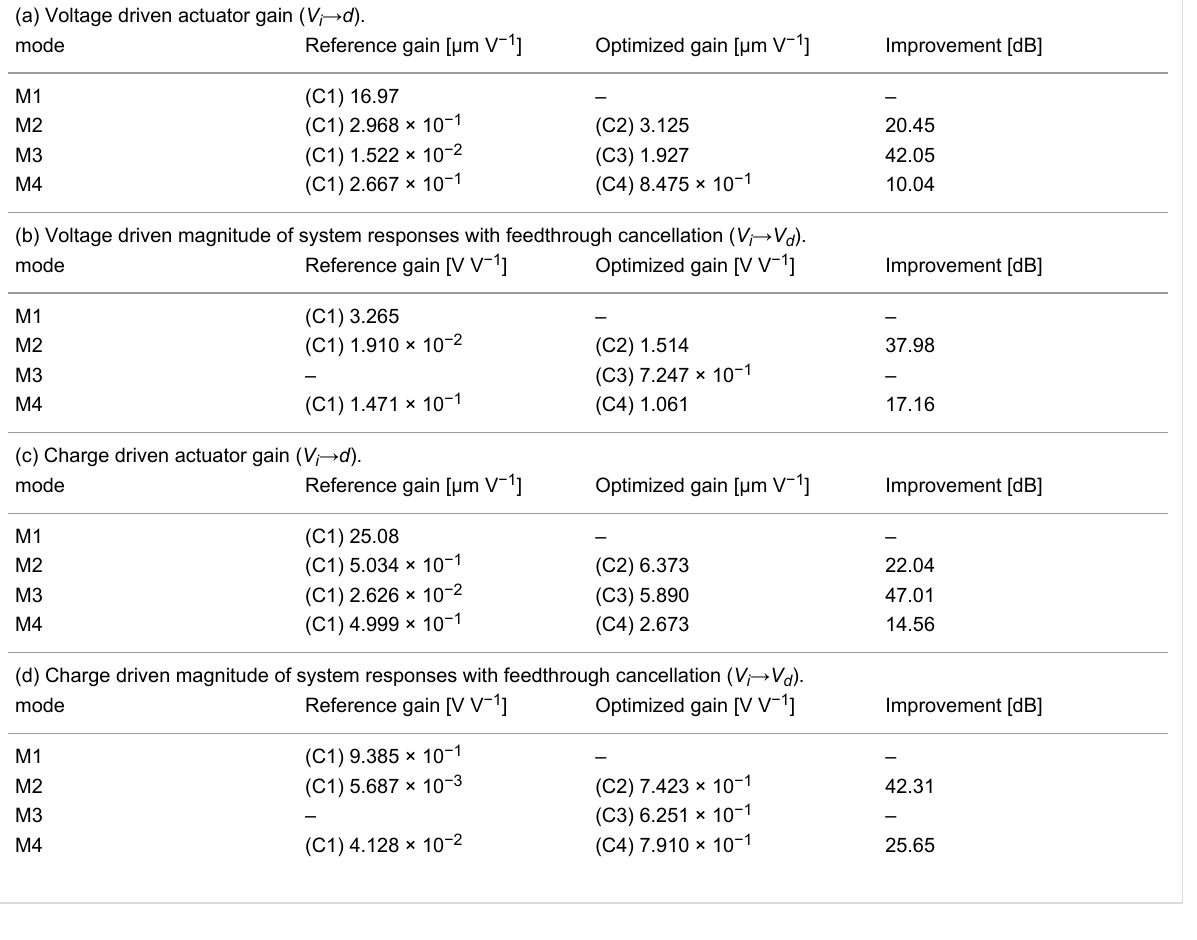
Table 2: Sensitivities of the reference cantilever C1 compared to the cantilevers with optimal transducer topologies. (a) Voltage driven actuator gain ( V i → d ).